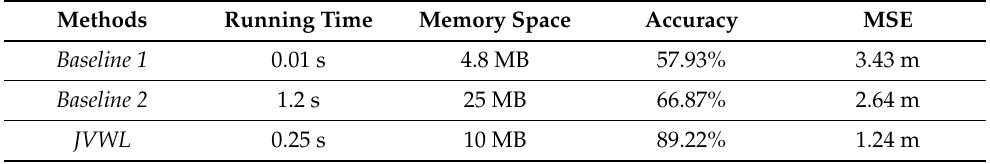
Figure 9. Localization trajectories for different schemes, including ground truth (yellow), JVWL (red), Baseline 1 (green), and Baseline 2 (blue). Table 3. Localization accuracy, total running time, and memory space comparison for different localization